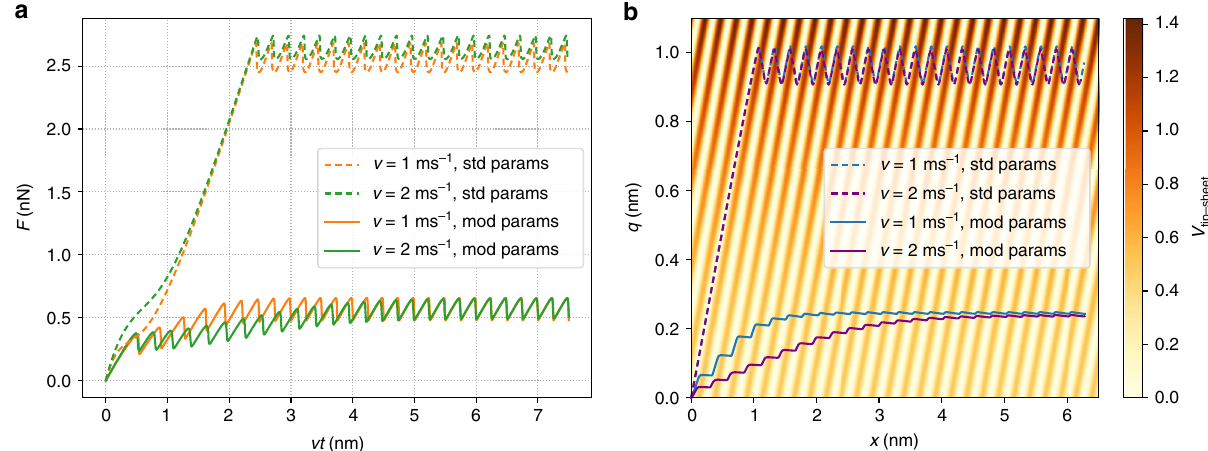
Fig. 6 The case with no substrate. Force traces ( a ) and xq -trajectories ( b ) for a system without a substrate. The frictional strengthening disappears for our chosen parameters (indicated by the abbrevaition “ std params ” ) but can be recovered by tuning the parameters (indicated by “ mod params ” ). Details of the parameters are given in the “ Methods ” section. The strengthening without the substrate is dynamic rather than quasi-static in nature, such that it depends on the velocity as well as the inertia m q